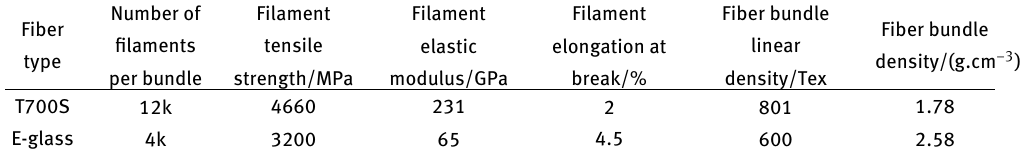
Table 3: Mechanical properties of textile